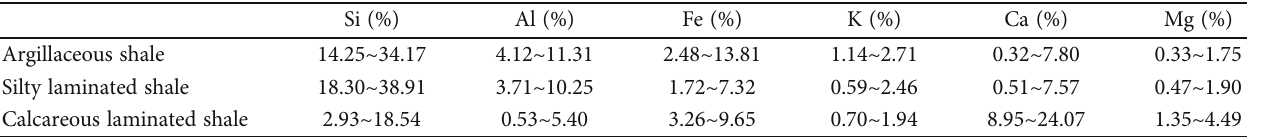
Table 4: Element concentration of three types of